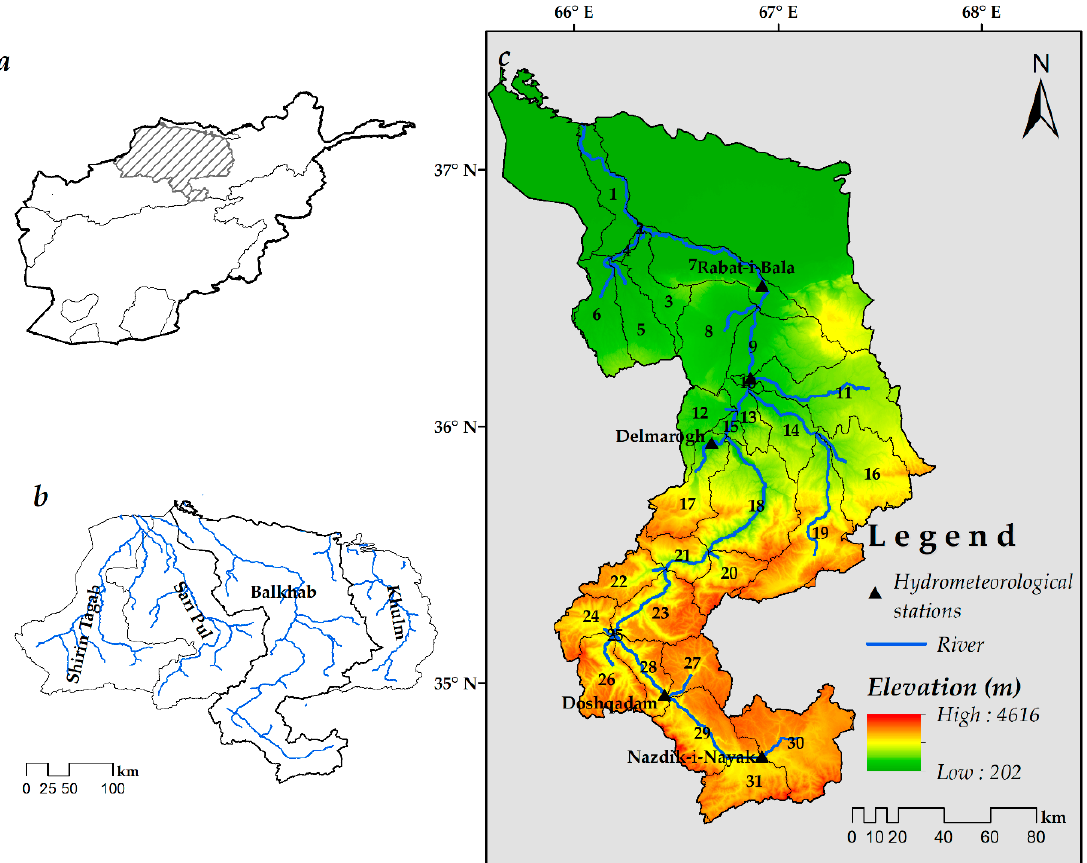
Figure 1. Study area map of the northern river basin, Afghanistan: ( a ) Afghanistan map and its division into 5 major basins; ( b ) Northern river basin with four subbasins: Khulm, Balkhab, Sari Pul, and Shirin Tagab; ( c ) Balkhab river basin, elevation map, and subbasins divisions.